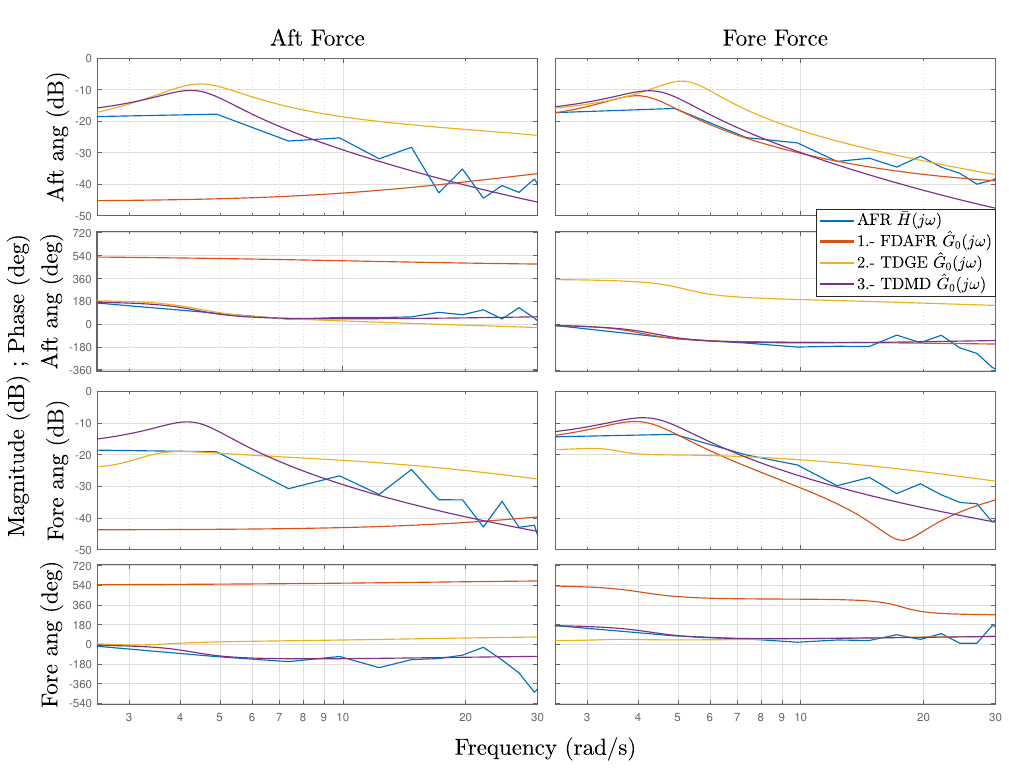
Figure 9. Average frequency response (AFR) ¯ H ( j ω ) and identified transfer functions ˆ G 0 ( j ω ) for each